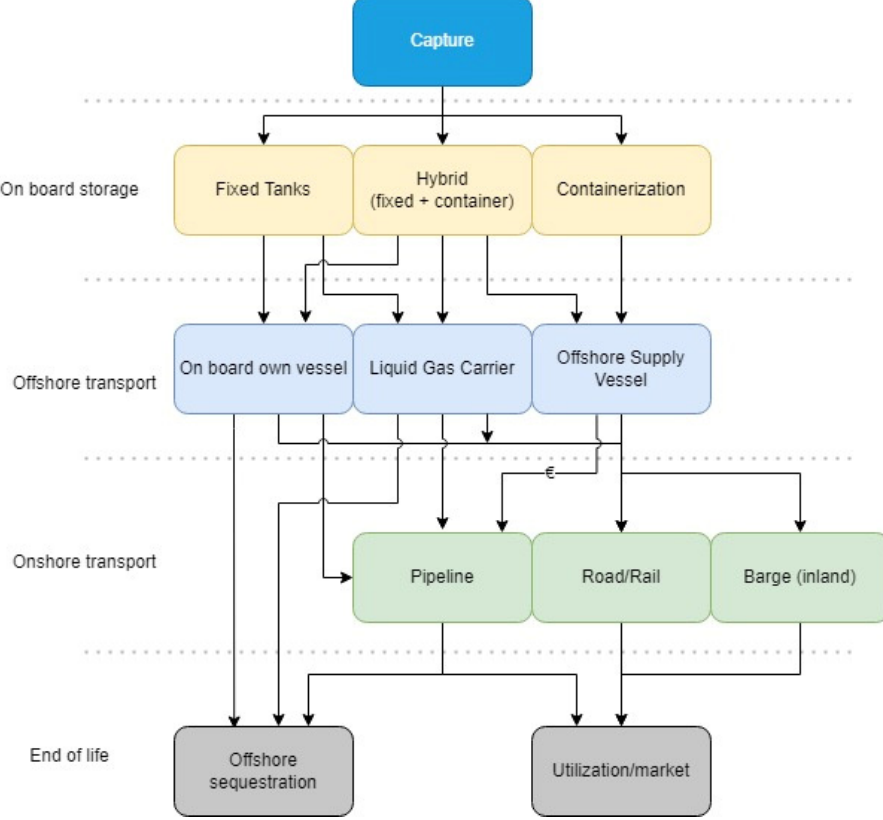
Figure 2. Graphical overview of technically feasible supply chain paths. The € symbol from OSV to pipeline indicates that this is a possible route, but very costly.